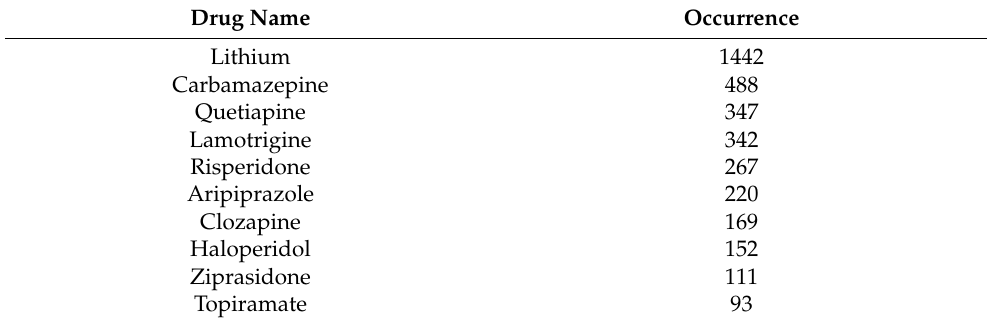
Table 3. The number of times specific drugs have been represented in relationship with Bipolar Disorder. After receiving data from the code, the data were organized, and then validated as treatment options currently